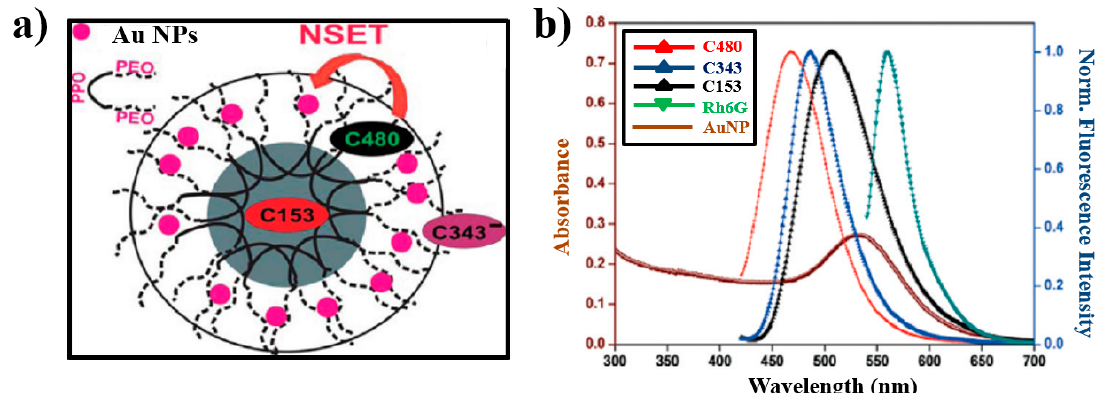
Figure 22. ( a ) Schematic illustration of P123 micelles and probe molecules at di ff erent positions. ( b ) Typical normalized spectra of P123 micelles and gold NPs [93].